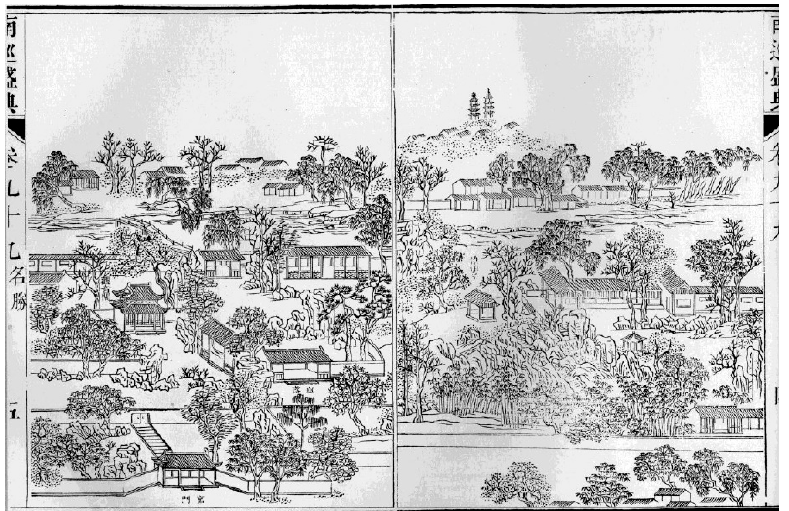
Figure 7. The Canglang Pavilion and its surroundings during the reign of Emperor Qianlong [53].